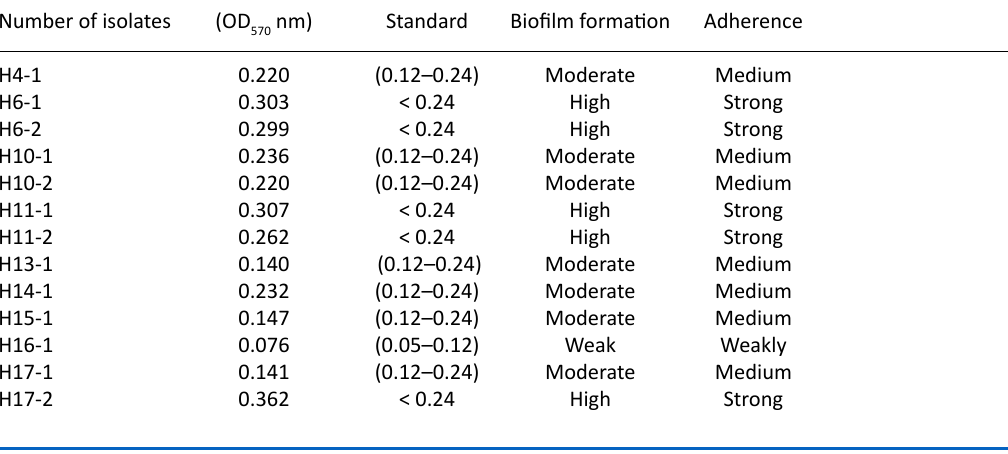
table 9. Biofilm formation by Tissue Culture Plate (TCP) at OD570 nm of Hungary cheeseisolates Number of isolates (OD nm) Standard Biofilm formation Adherence 570